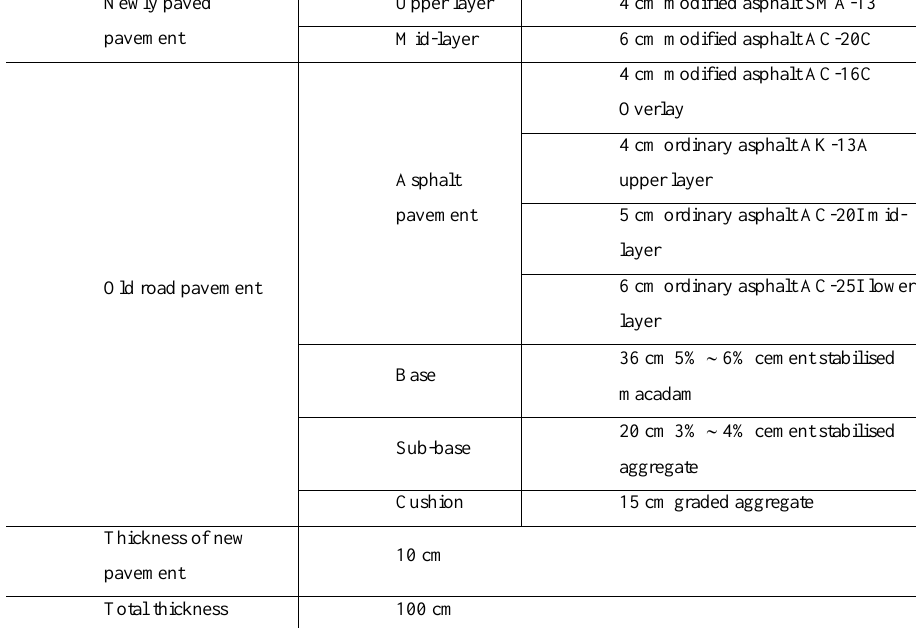
Table 1 Scheme of old pavement